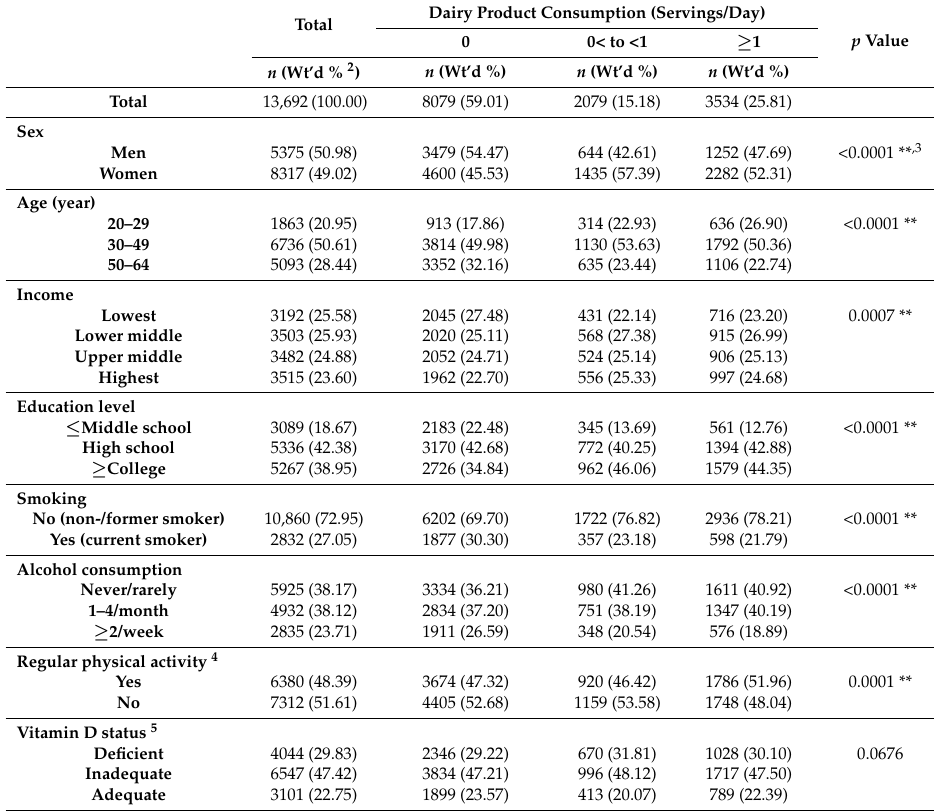
Table 1. General characteristics of the study population by dairy product consumption in Korean adults, KNHANES 2010–2013 1 .